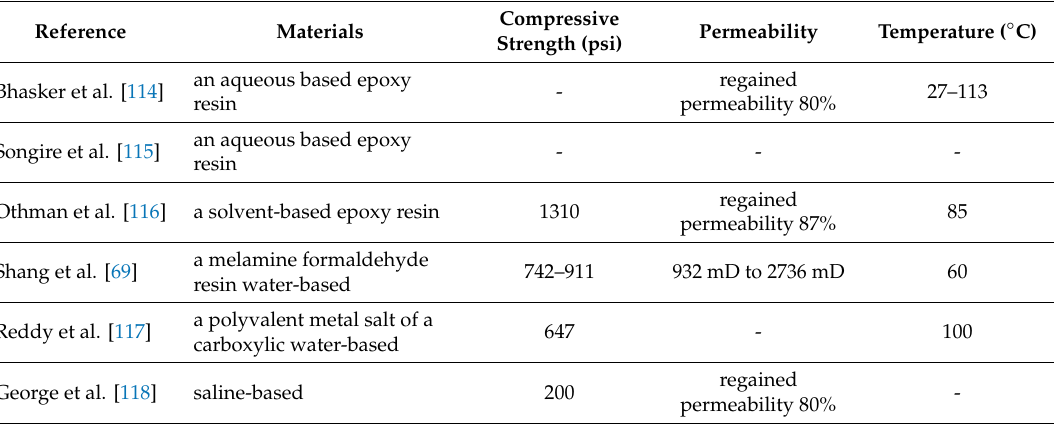
Table 23. Water-based and saline-based methods to consolidate sand formation.